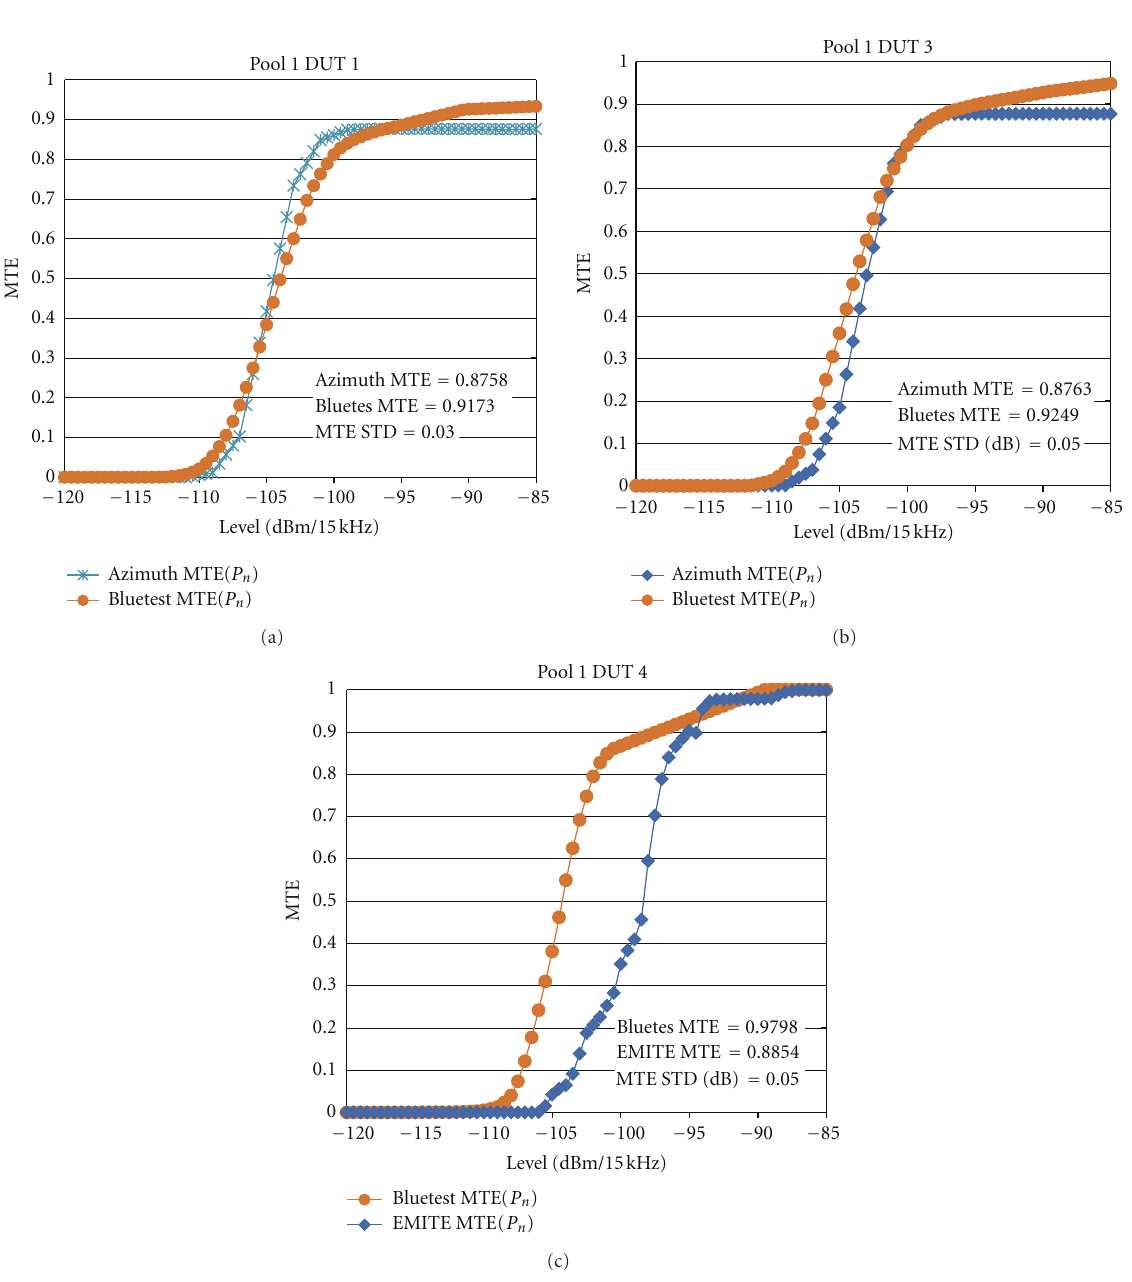
Figure 1: MTE for Pool 1 with the RC